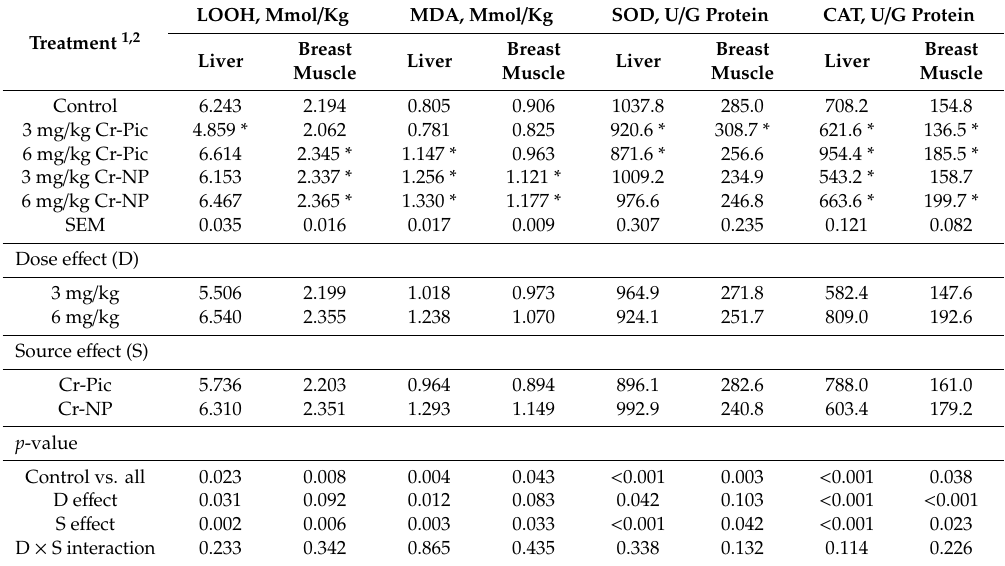
Table 4. Content of redox indicators in the liver and breast muscle of the chickens receiving di ff erent sources of